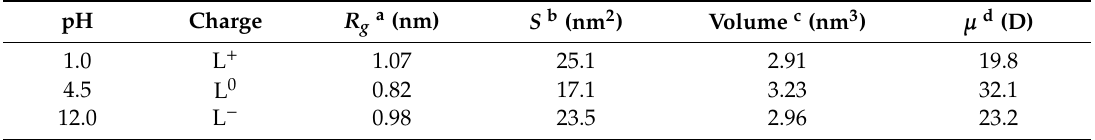
Figure 5. ( a ) Main chain molecular conformations in water at the end of the MD runs for M- l -Gln at pH 1.0, 4.5, and 12.0 and torsion angle distributions around the main chain bonds: the histogram are shown with a binning of 300 K. C atoms: dark grey; H atoms: light grey; N atoms: blue; O atoms: red. ( b ) Solvent accessible surface area in water. Surface area near C atoms: dark grey; near H atoms: light grey, near N atoms: blue; and near O atoms red. ( c ) Dipole moments in water. Color codes are the same as in panel ( a ). Table 3. Properties of the simulated M- L -Gln decamer at different pH values in water at the end of the MD runs and final geometry optimization.